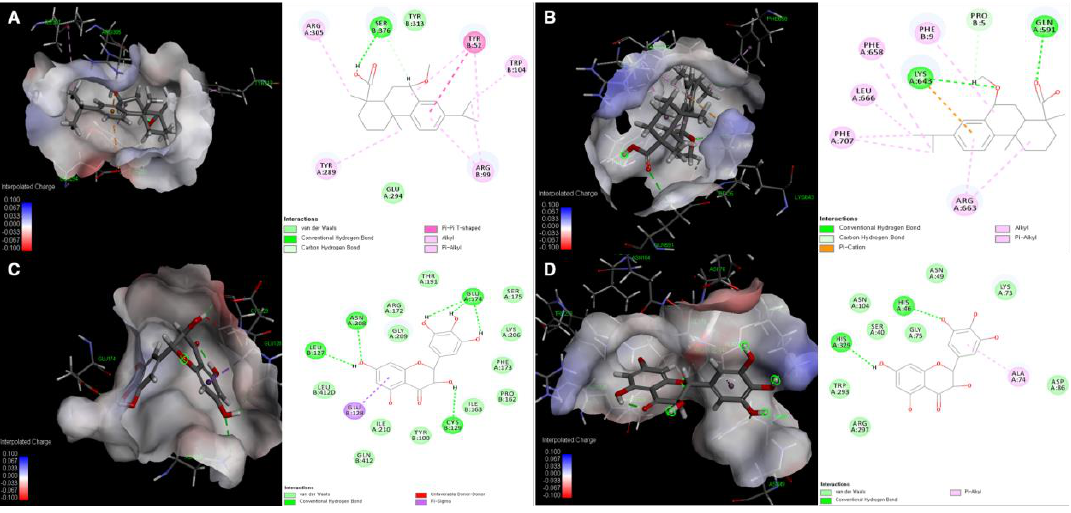
Figure 6. Illustration of the molecular docking simulation and 2D diagram of the interactions between ( A ) NP and compound 5 , ( B ) PA-PB1 and compound 5 , ( C ) NA and compound 24 , and ( D ) NA mutant and compound 24 using Discovery Studio Client v19.1.0.18287/CDOCKER software. The structures of the proteins were obtained from the Protein Data Bank (http://www.pdb.org) (PDB ID code : 3RO5, 2ZNL, 3TI4, and 3CL0 for A-D, respectively).